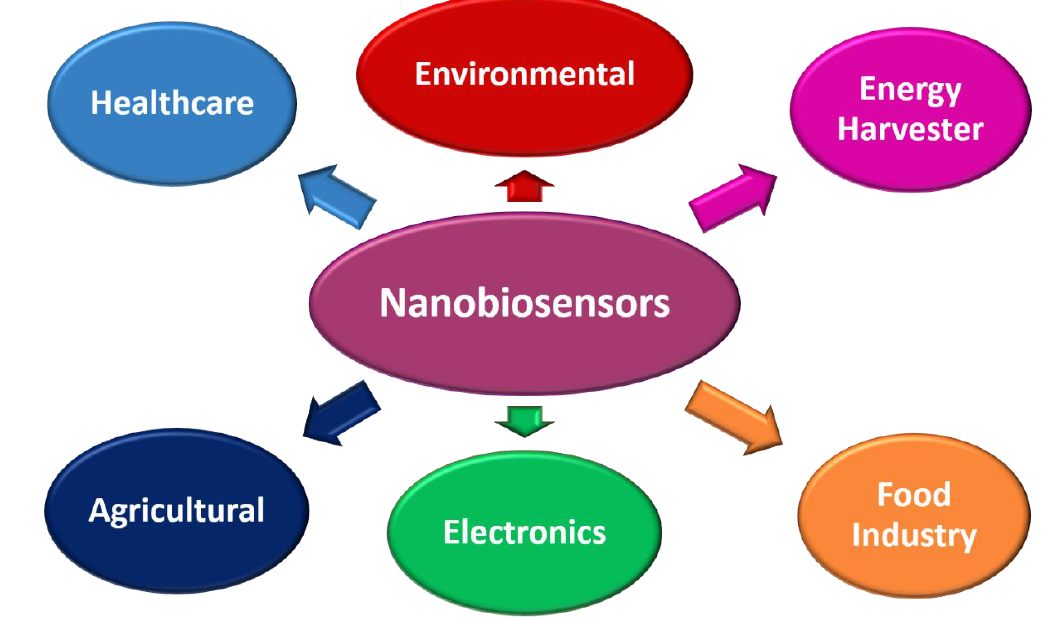
Figure 6. Schematic of several applications of nanobiosensors.